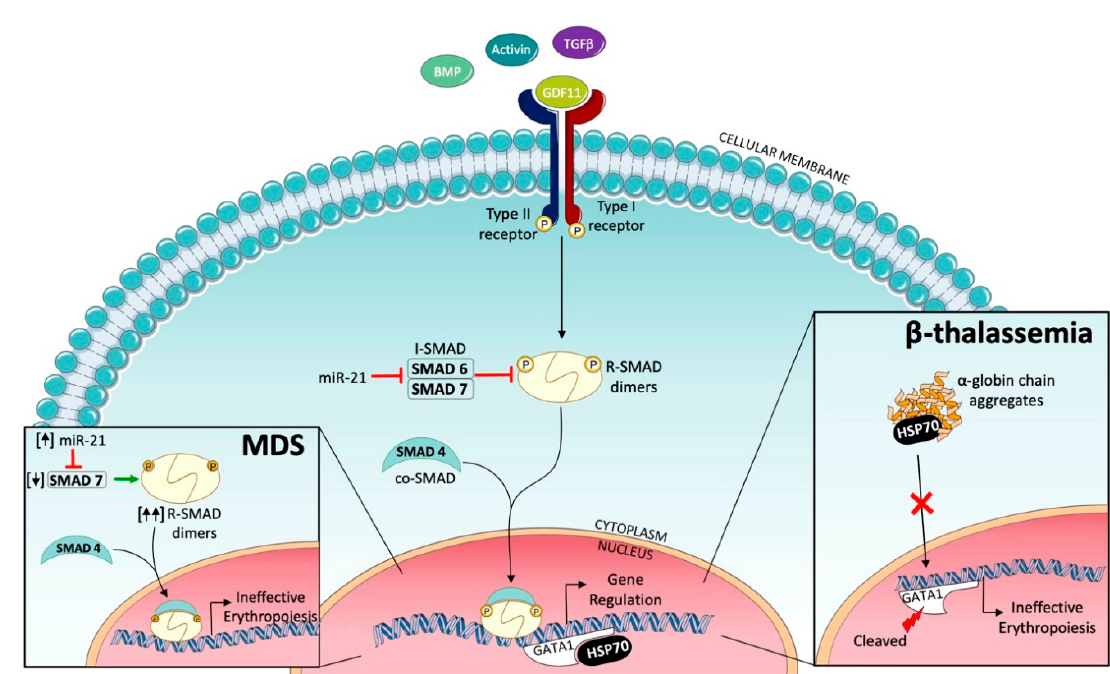
Figure 2. Erythropoiesis regulation by TGF- β superfamily signaling in physiologic and pathologic conditions, particularly in myelodysplastic syndromes (MDS) and β -thalassemia. Following ligand binding to the type II receptor, the type I receptor is recruited and phosphorylated. TGF- β induces the phosphorylation of regulatory SMADs (R-SMADs), SMAD2 and 3, to form the complex R-SMAD/SMAD4, which modulates the expression of target genes. MDS patients display an overactivation of SMAD2/3 signaling due to the altered expression of mir-21 and SMAD7, which in turn induce ineffective erythropoiesis. In β -thalassemia, aggregates of α -globin sequester heat shock protein 70 (HSP70), inhibiting its translocation to the nucleus and protection of GATA1 from cleavage, leading to ineffective erythropoiesis.